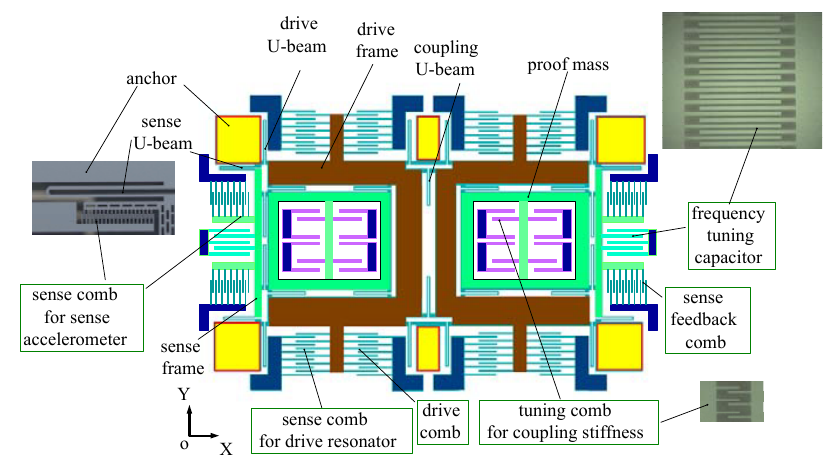
Figure 14. The silicon micro-gyroscope evaluated in the experiments